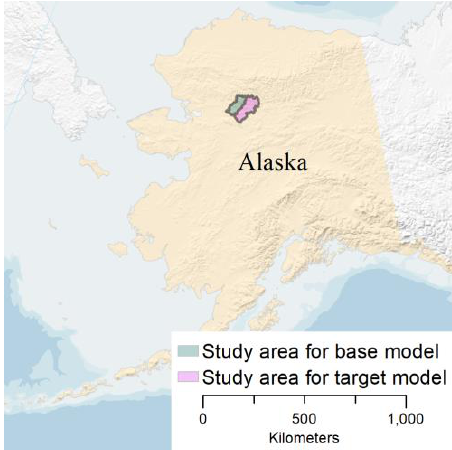
Figure 1. Location of areas in Alaska for base neural network model and target transfer learning model.